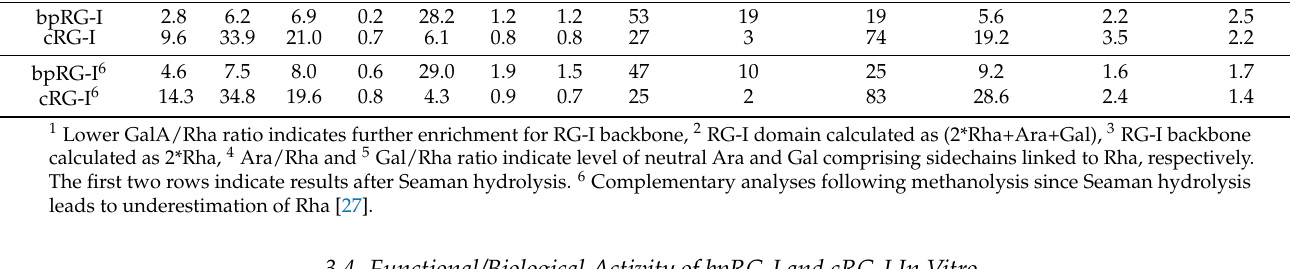
Table 4. Monosaccharide composition of the bpRG-I and cRG-I extracts enriched for RG-I at industrial-scale. Monosaccharides %